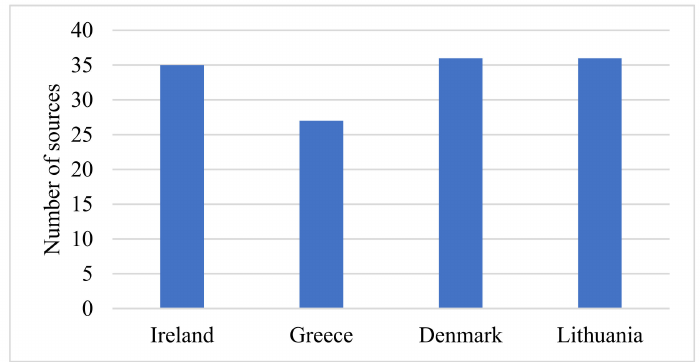
Figure 5. Sources by countries examined (designed by the